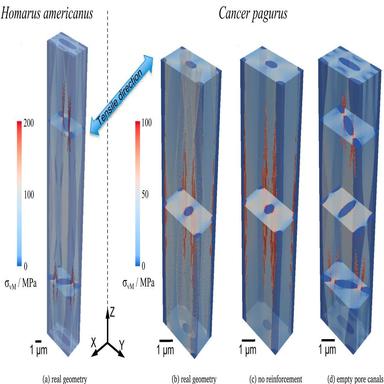
3D VON MISES stress field maps obtained from spectral method calculations applying in-plane uniaxial tension at strains that are close to experimental fracture values obtained for endocuticle of the lobster (a), and the crab (b–d). Representative Volume Elements (RVEs) (a) and (b) represent geometries as found in nature, while (c) and (d) represent hypothetical cases where structural parameters of the pore canals were altered by removing the pore canal reinforcement phase and modifying the pore canal volum